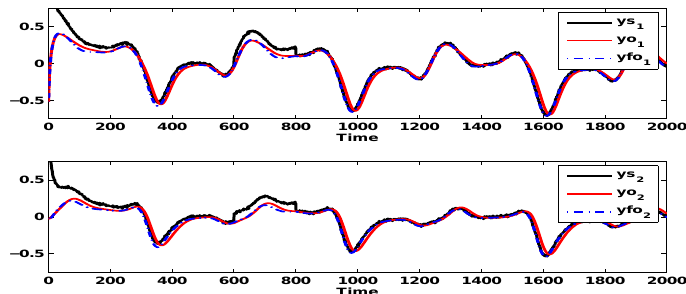
Figure 5. Outputs for the FOTS system and its estimation by FUIO and FOUIO in a faulty